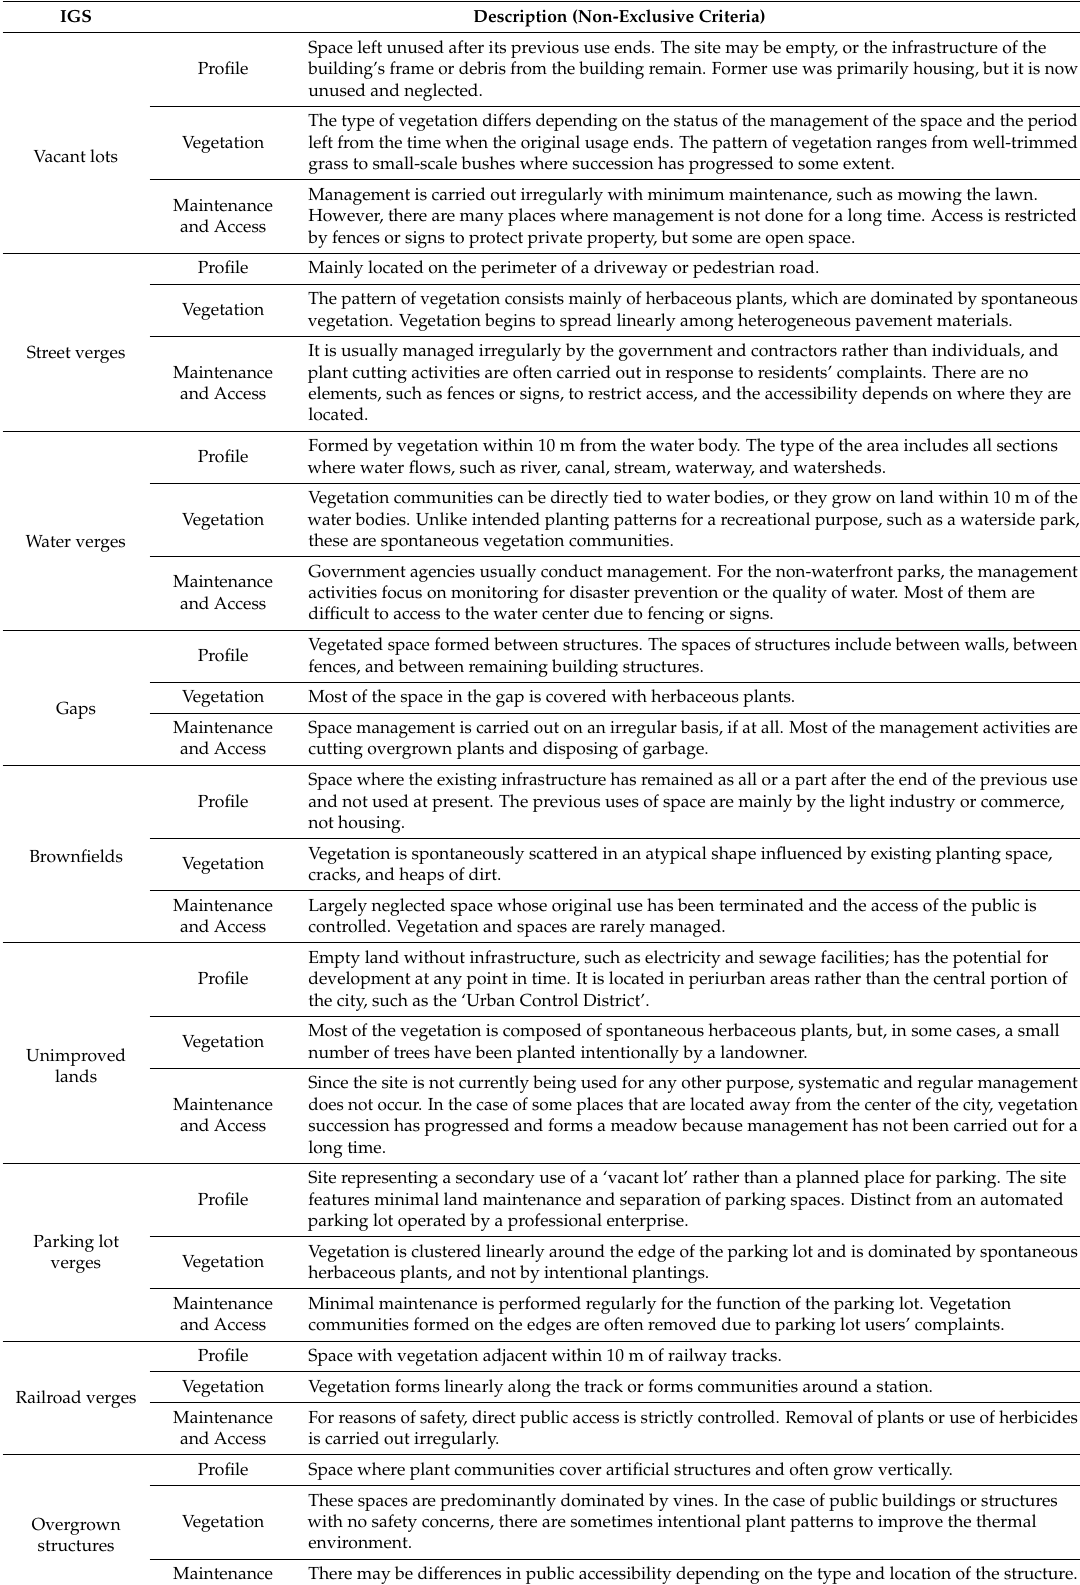
Table 1. Description of the nine types of informal urban green space